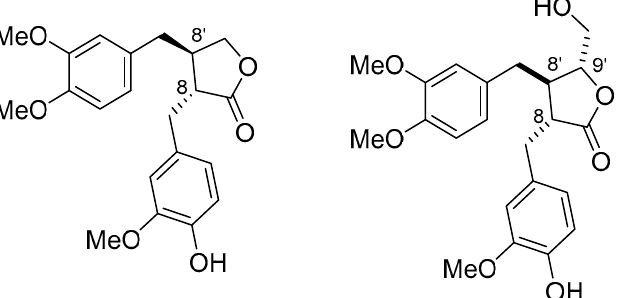
Figure 1. Arctigenin ( left ) and racemic C-9 ′ methylenehydroxy analogue ( right ).